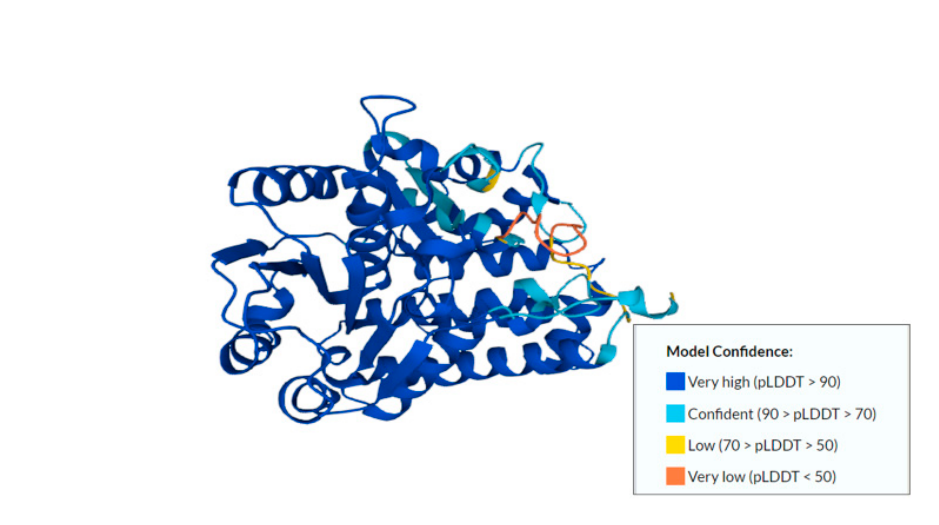
Figure 9. Predicted protein structure of alcohol dehydrogenase 3 [41,107,113] (https://www.uniprot.org/uniprotkb/Q24857/entry, accessed on 25 October 2022).